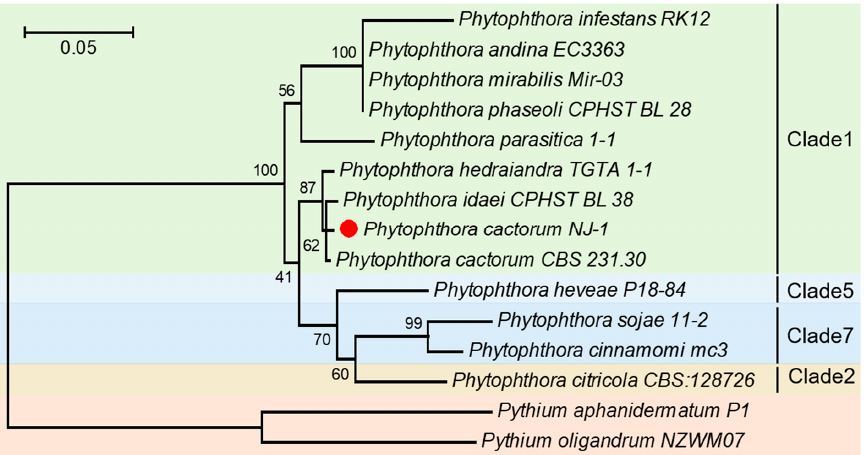
Figure 2. Molecular phylogenetic analysis by Maximum Likelihood method. The evolutionary history was inferred by using the Maximum Likelihood method based on the Tamura-Nei model. The tree with the highest log likelihood ( − 3414.8106) is shown. The percentage of trees in which the associated taxa clustered together is shown next to the branches. Initial tree(s) for the heuristic search were obtained automatically by applying Neighbor-Join and BioNJ algorithms to a matrix of pairwise distances estimated using the Maximum Composite Likelihood (MCL) approach, and then selecting the topology with superior log likelihood value. The tree is drawn to scale, with branch lengths measured in the number of substitutions per site. The analysis involved 15 nucleotide sequences. Codon positions included were 1st + 2nd + 3rd + Noncoding. All positions with less than 95% site coverage were eliminated. That is, fewer than 5% alignment gaps, missing data, and ambiguous bases were allowed at any position.